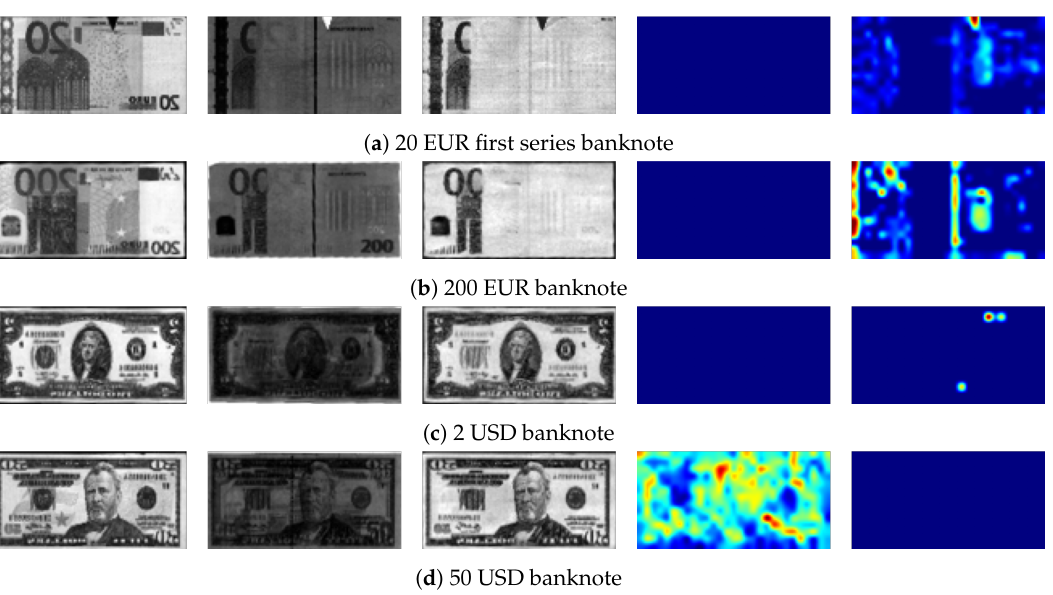
Figure 1. Grad-CAM results for some example banknotes. The most left column to the third column show visible, infrared transmission, and infrared reflection images of banknotes. The forth column and the most right column show Grad-CAM results for banknote recognition and counterfeit detection,